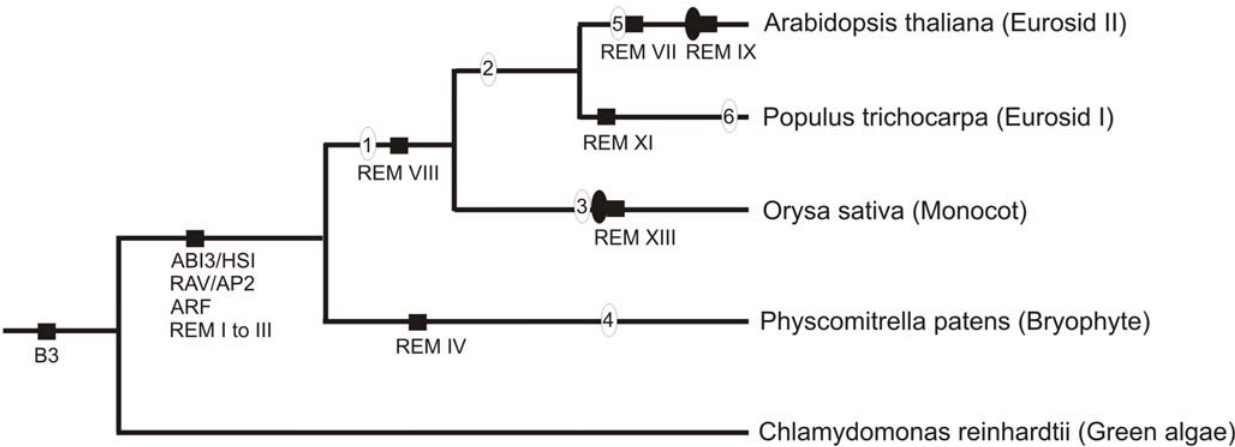
Figure 9. Schematic representation of the phylogeny of the B3 superfamily during plant evolution. Circles with a number inside denote large-scale duplication events: 1, , 143–220 MYA [52]; 2, , 66–109 MYA [50,51]; 3, , 50–60 MYA [39,50]; 4, , 30–60 MYA [53], , 24–40 MYA [38]; and 6, , 8–13 MYA [40]. Solid black circles denote recent tandem duplication for B3 genes discovered in this study. The solid black squares, family or class names denote origin of the B3 families during